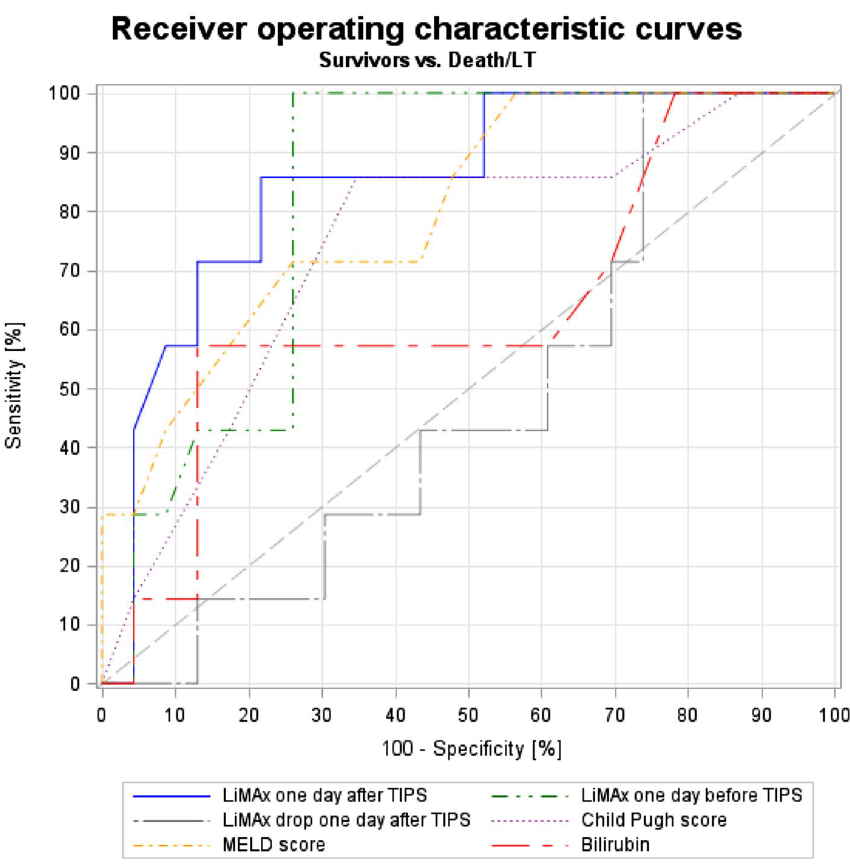
Figure 4. Receiver operating characteristics (ROC) curves of five parameters with highest AUROC values and LiMAx drop in prediction of transplant-free survival after TIPS